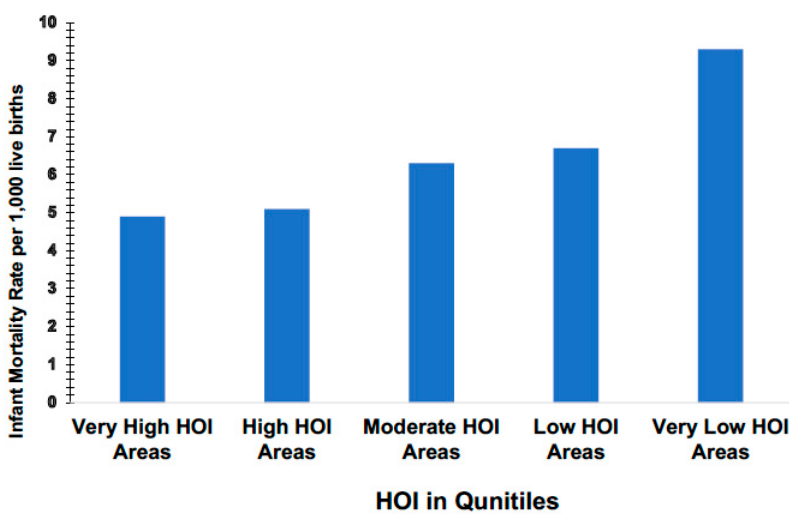
Figure 2. Health Opportunity Index Scaled into Quintiles against infant mortality to show the relationship. Data shows that the infant mortality rate in “Very High Opportunity Areas” on average is 47.3% lower than the rate in “Very Low Opportunity Areas”.